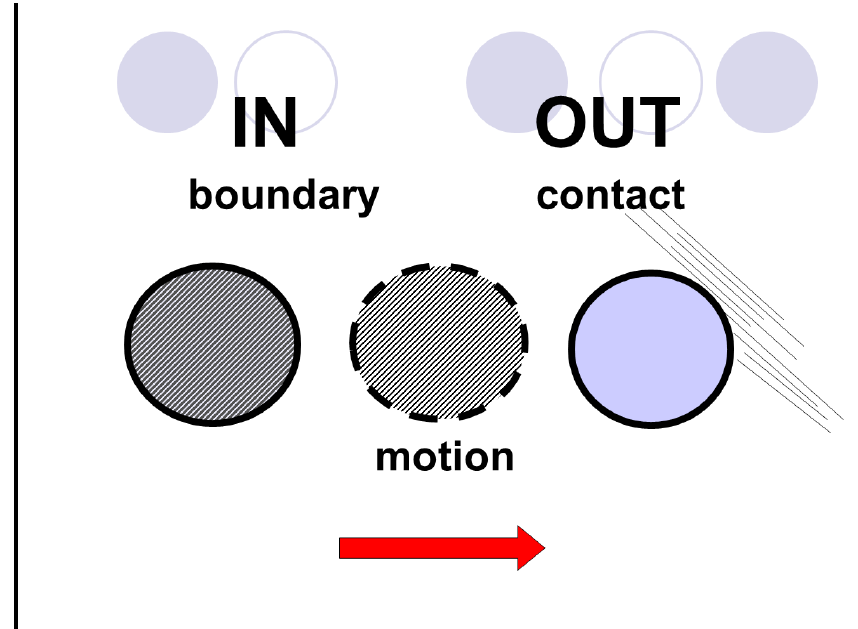
Figure 1 - Primitive spatial meanings DOI: https://doi.org/10.18454/RULB.2023.38.1.1